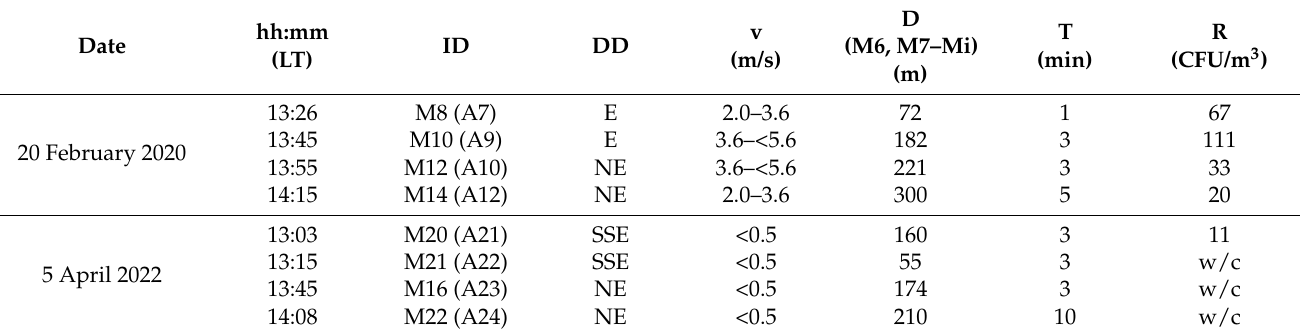
Table 4. E. coli concentration per m 3 of air (R, CFU/m 3 ), sampling site (ID), wind direction (DD), wind speed (v, m/s), distance between the sampling site and the pen with the highest E. coli concentration